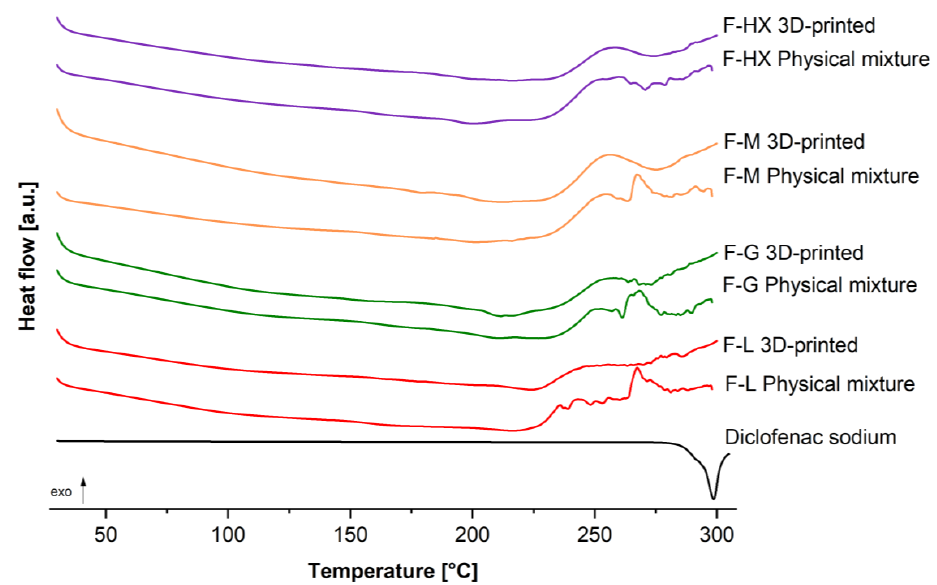
Figure 4. DSC thermogram of diclofenac sodium and different extrusion and 3D-printed formulations (F-L, F-G, F-M, F-HX).